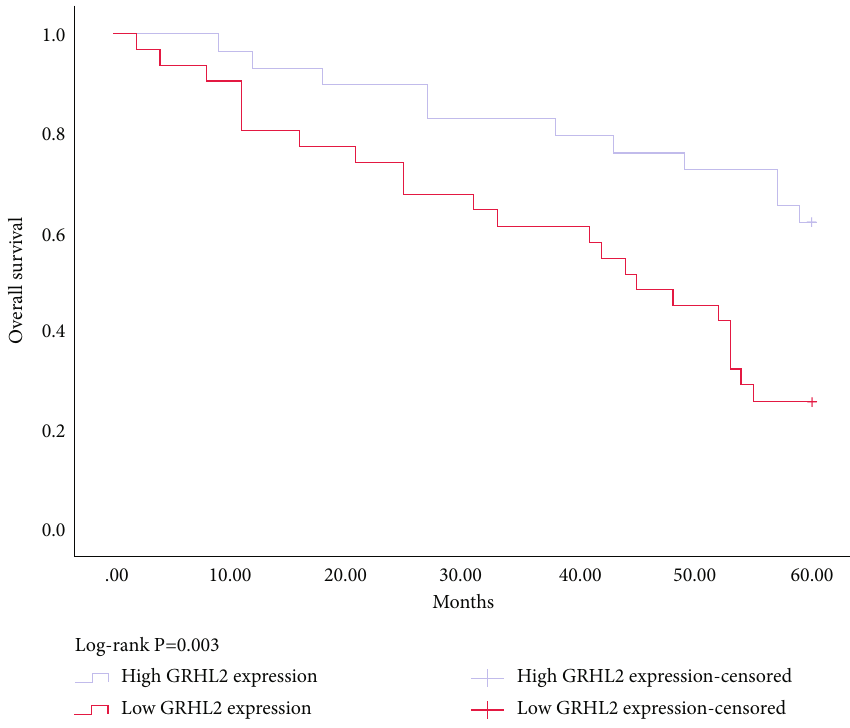
Figure 2: The relationship between GRHL2 expression level and prognosis in patients with acute